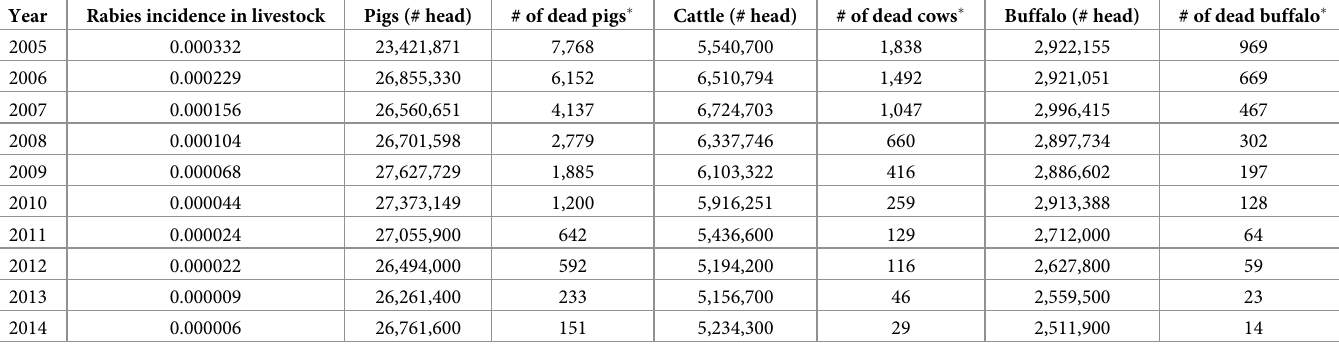
Table 4. Incidence of canine rabies and corresponding deaths in livestock between 2005 and